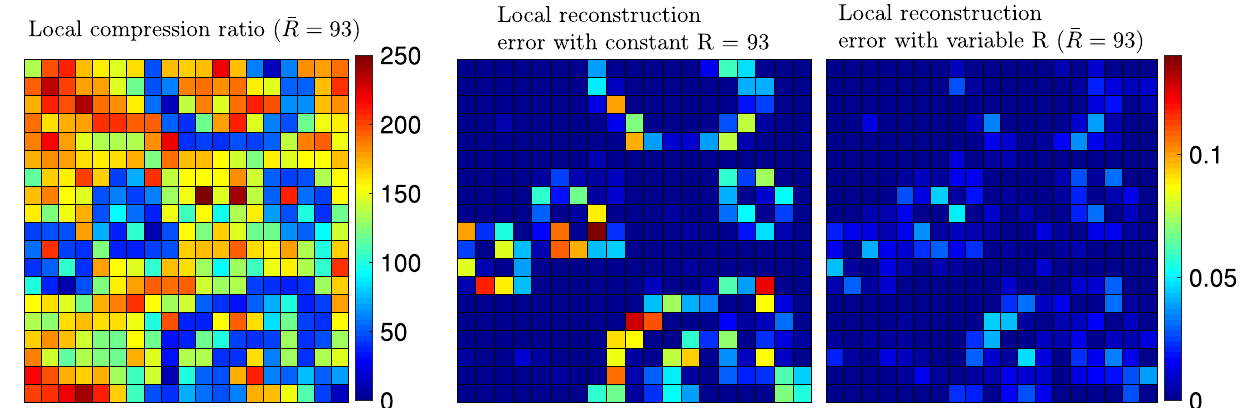
Fig. 14 Plots showing ( left ) the local optimal compression ratio R that is used to reconstruct the velocity magnitude U field shown in Fig. 13, ( middle ) the local NRMS error obtained when the same